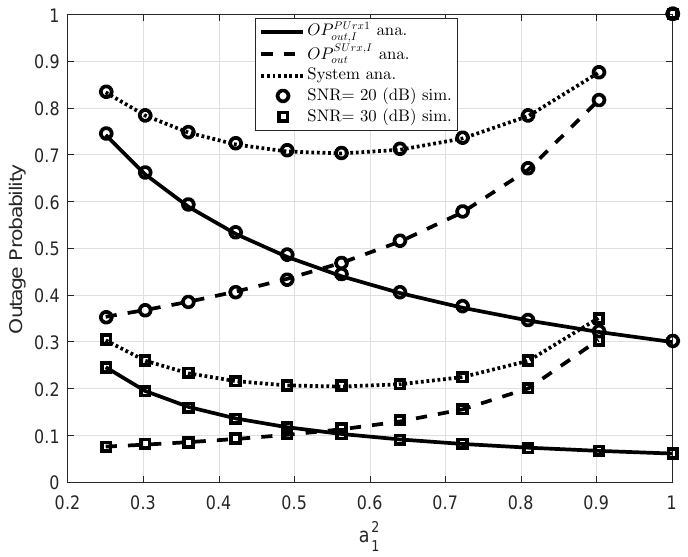
and SNR ( R PUrx 1 = 1